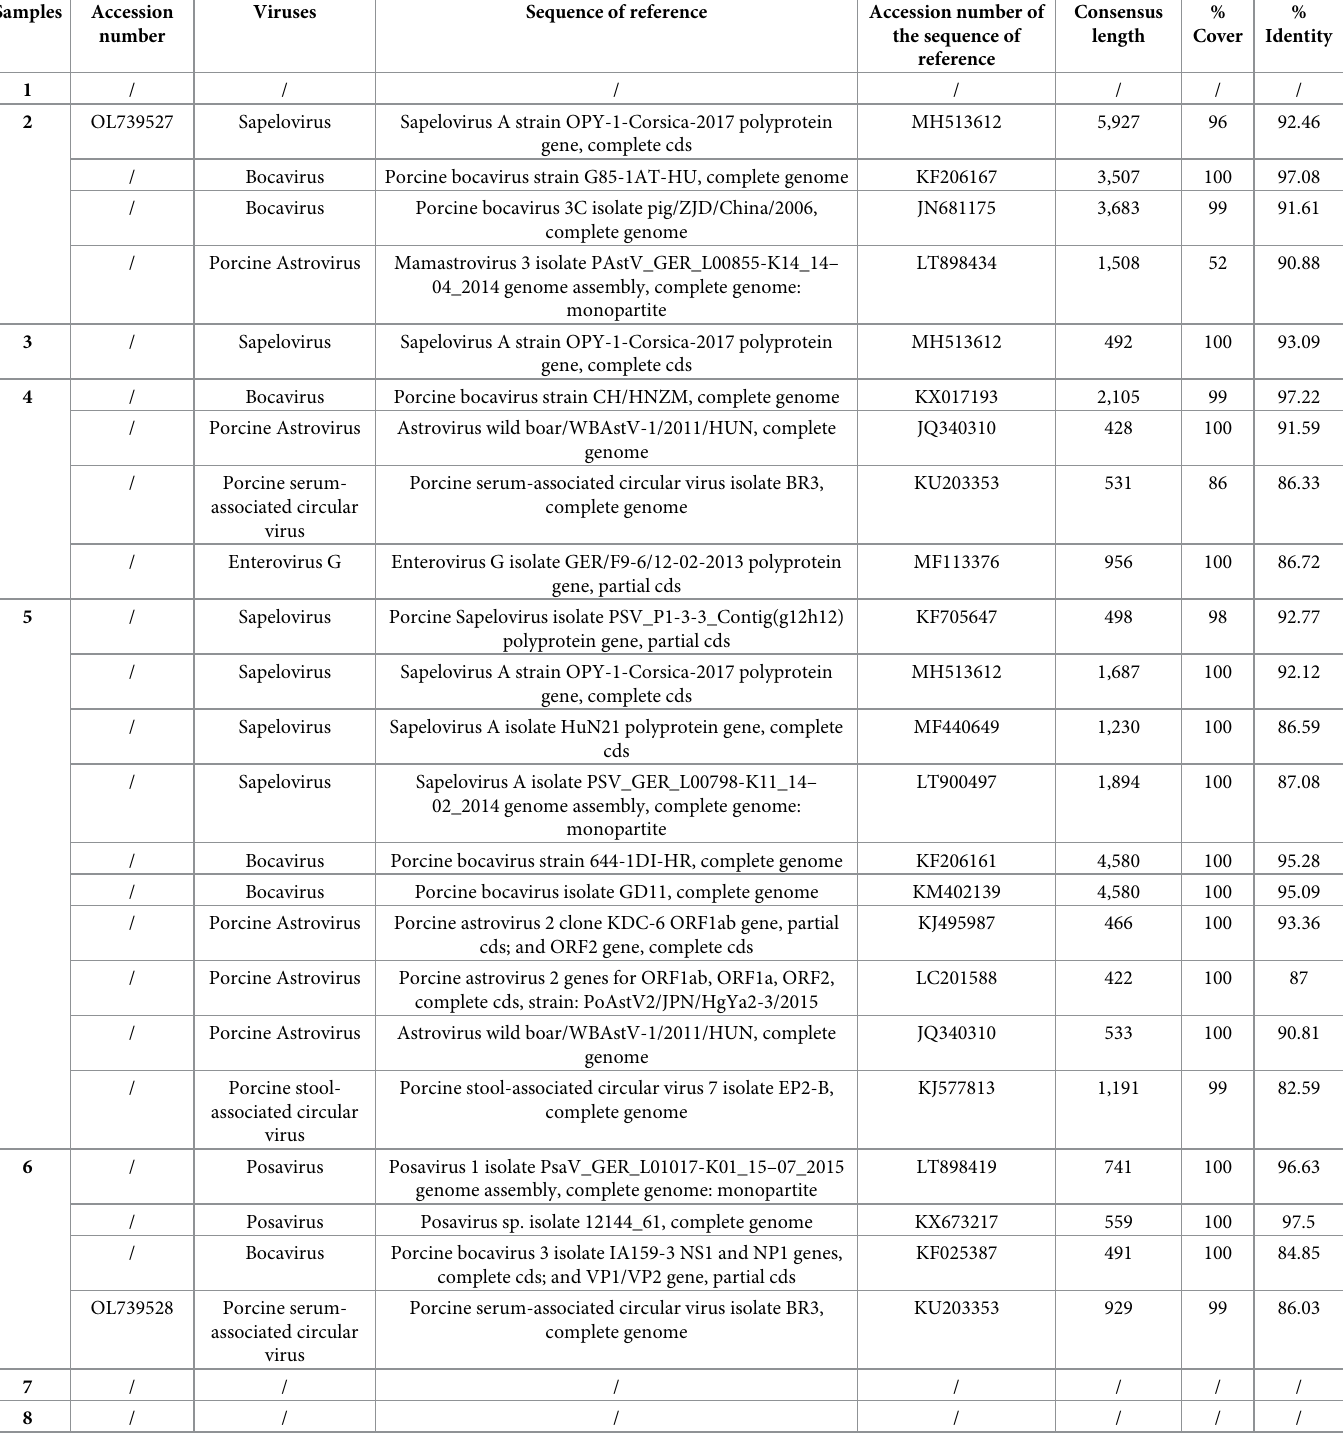
Table 5. Diversity of sequences found in pig feces and percentage of identity with strains in the literature.